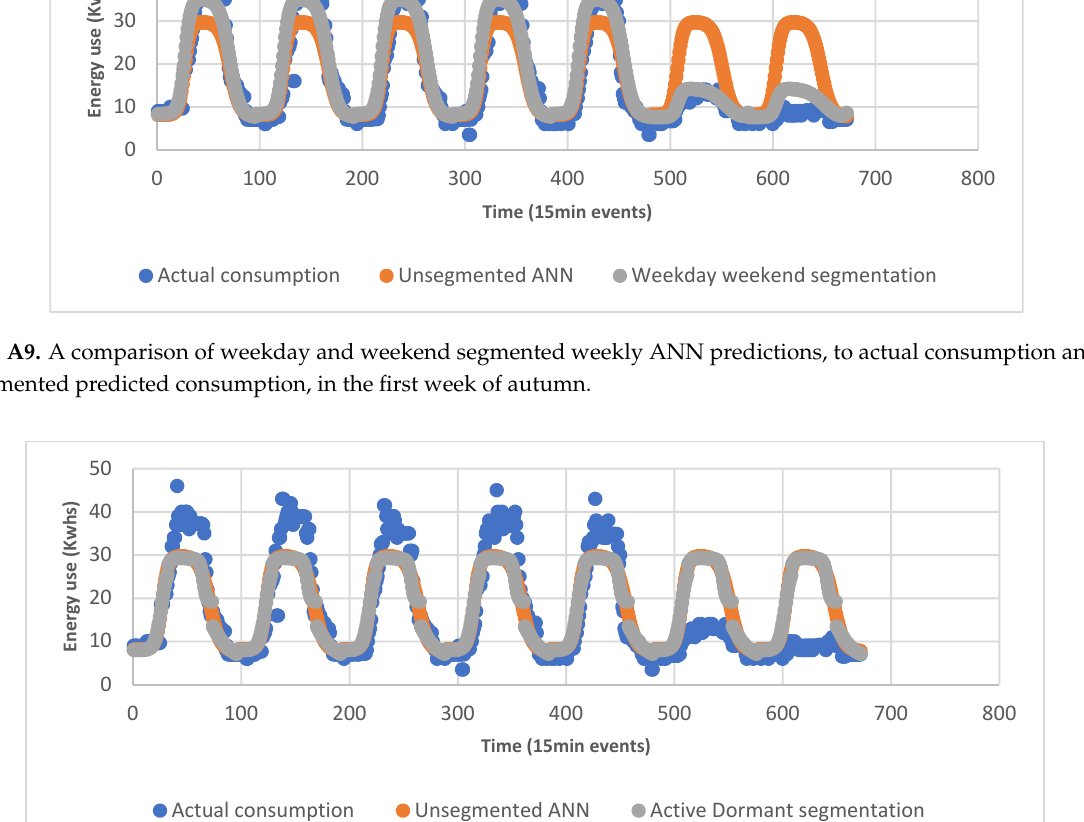
Figure A10. A comparison of building active and dormancy period segmented weekly ANN pre-